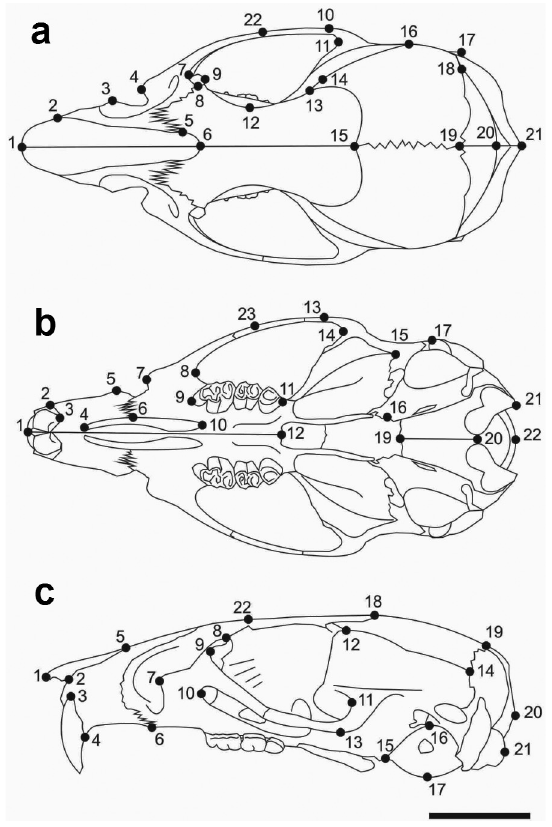
Figure 2 - Landmark locations on dorsal (a) , ventral (b) and lateral (c) views of skull of Scapteromys tumidus . Detailed description of the location of landmarks is given in Appendix